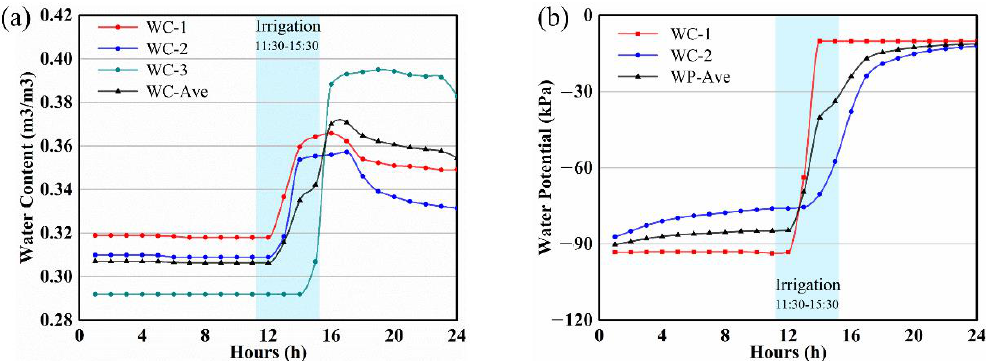
Figure 6. Changes of soil water content ( a ) and soil water potential ( b ) in 24 h.